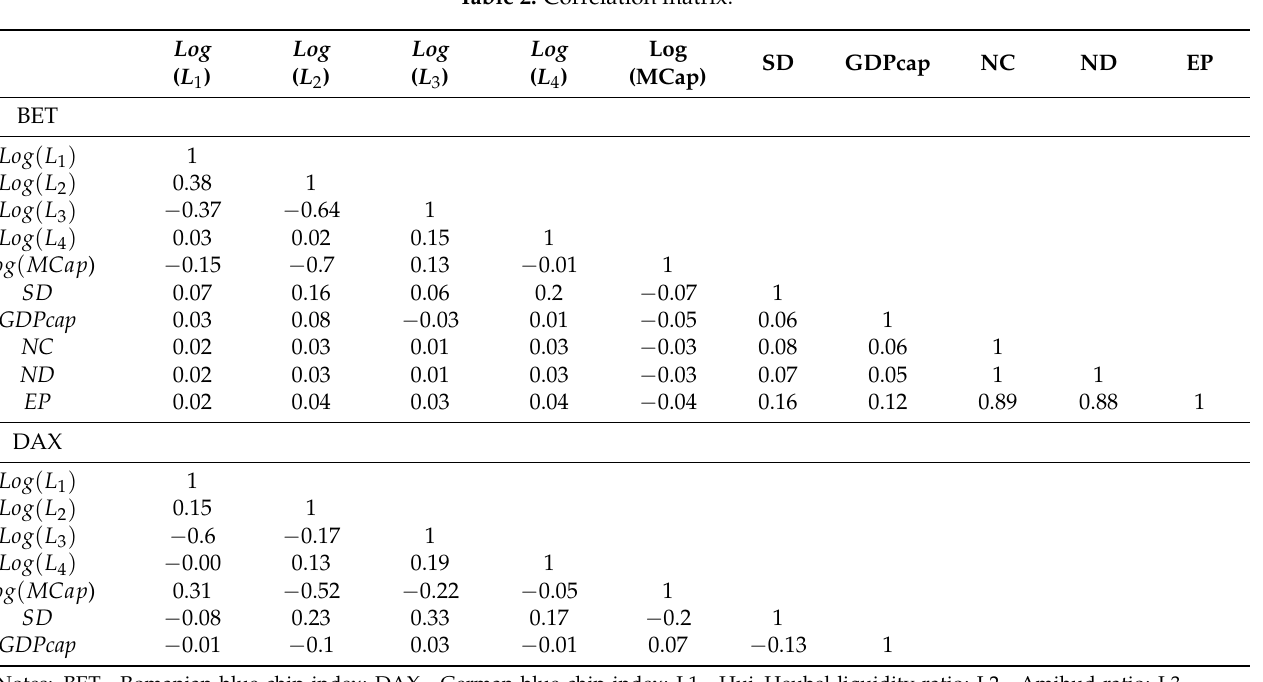
Table 2. Correlation